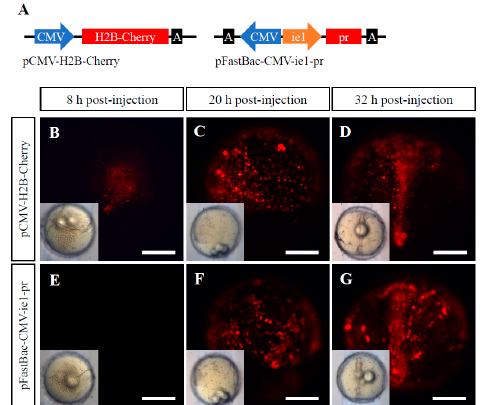
Figure 5. The activity of the WSSV ie1 promoter in medaka embryos. ( A ) Rough sketch of pCMV-H2B-Cherry and pFastBac-CMV-ie1-pr that were used for microinjection into fish embryos. In pCMV-H2B-Cherry, a H2B-cherry cassette was driven by a CMV promoter, and the H2B polypeptide was a nuclear localization signal. In pFastBac-CMV-ie1-pr, a pr cassette was driven by a WSSV ie1 promoter. A, poly(A). ( B – G ) The RFP expressions in medaka embryos where the plasmids pCMV-H2B-Cherry or pFastBac-CMV-ie1-pr were injected. Scale bar, 500 μ m.